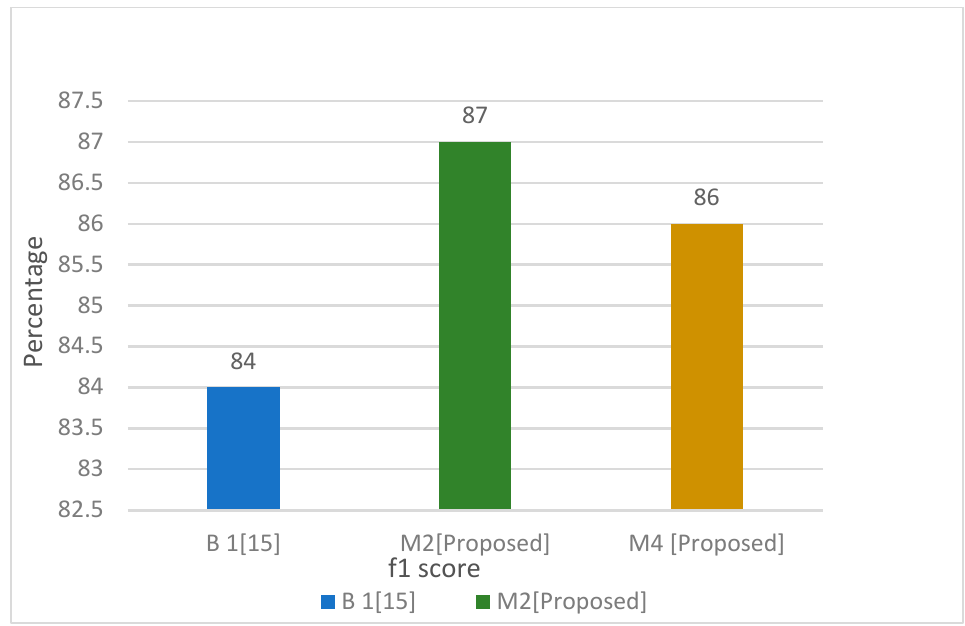
Figure 16. M Sadiq, S (2021) Model vs. Best Fit Proposed Models (Unigram + Bigrams) in Terms of F1 Score.